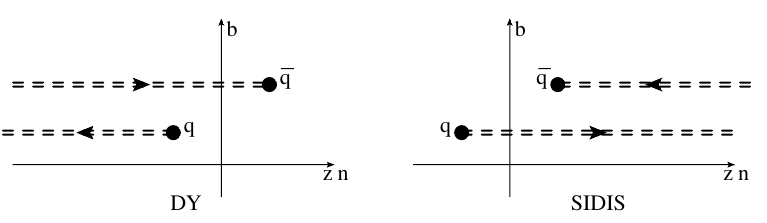
Figure 1 . Illustration for the de(cid:12)nition of TMD operators in DY and SIDIS. The Wilson lines (shown by dashed lines) are oriented along past (DY) or future (SIDIS) light cone direction. At light-cone in(cid:12)nities the Wilson lines are connected by transverse gauge links (not shown). that appear in SIDIS have Wilson lines pointing to + 1 n , while in Drell-Yan they point to (cid:0)1 n as in (cid:12)gure 1. The Wilson lines within the TMD operator are along the light-like direction n